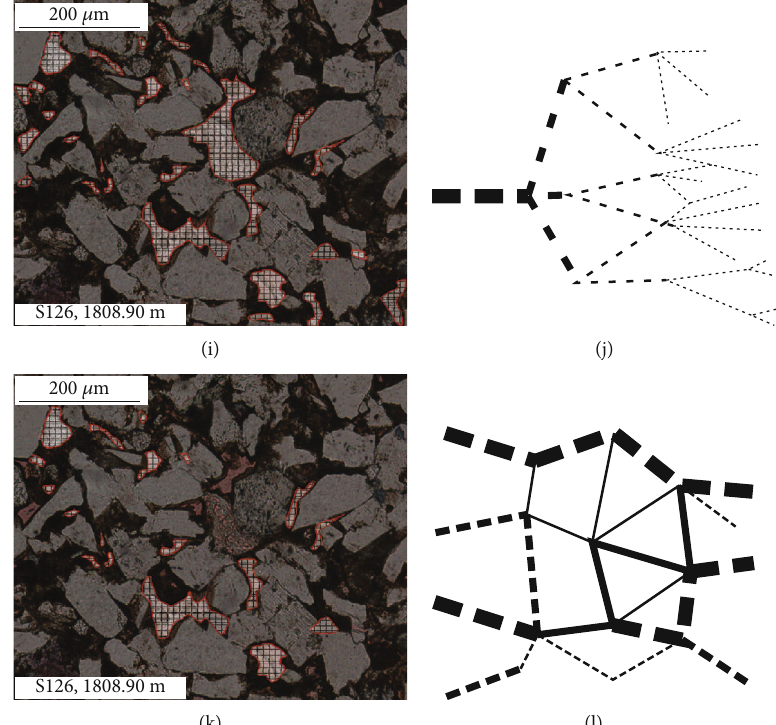
Figure 5: TS observations and multitype model (solid line represents mercury fi lling the voids, dashed line represents wetting phase fi lling the voids, and line thickness represents the diameters of pore throats).